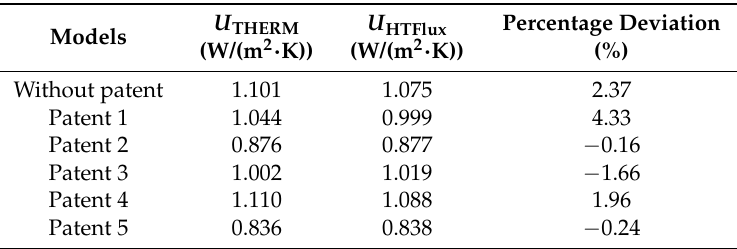
Table 4. Results of thermal transmittance obtained for each constructive solution analysed using THERM and HTFlux software, and the existing difference.